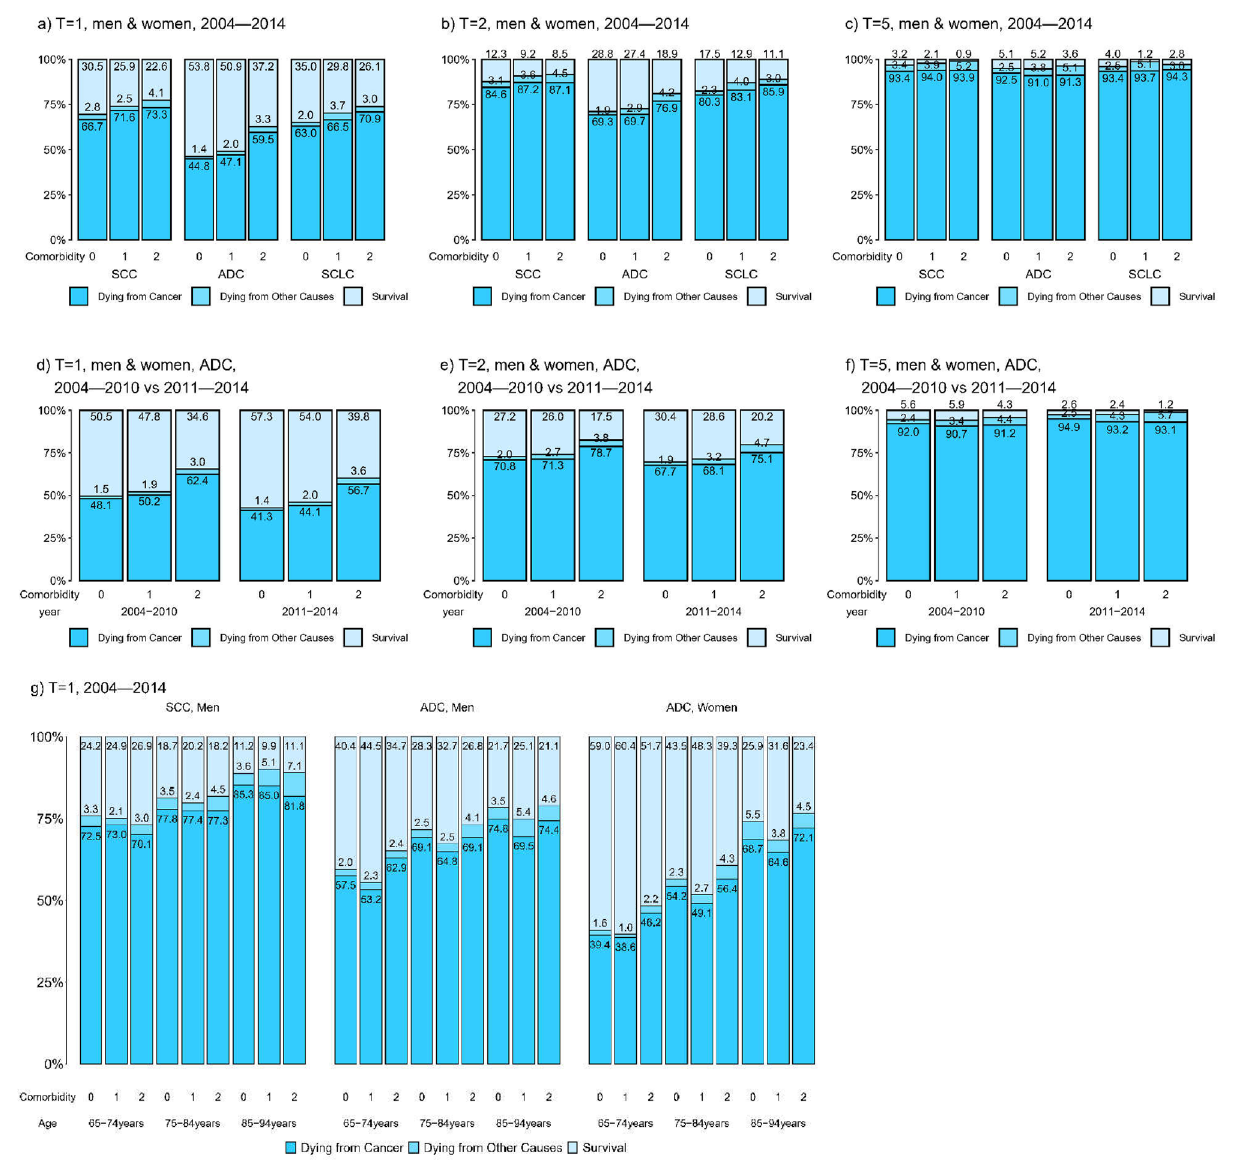
Figure 5. T-year probabilities of dying from cancer, dying from other causes, and survival stratified by comorbidity level, subtype and year at diagnosis for patients with distant lung cancer aged 30–94. Panels a, b, and c compares the one-, two- and five-year survival among subtypes. Panels d, e, f compares the one-, two, and five-year survival between calendar year periods. Panel g compares one-year survival between male SCC, male ADC, and female